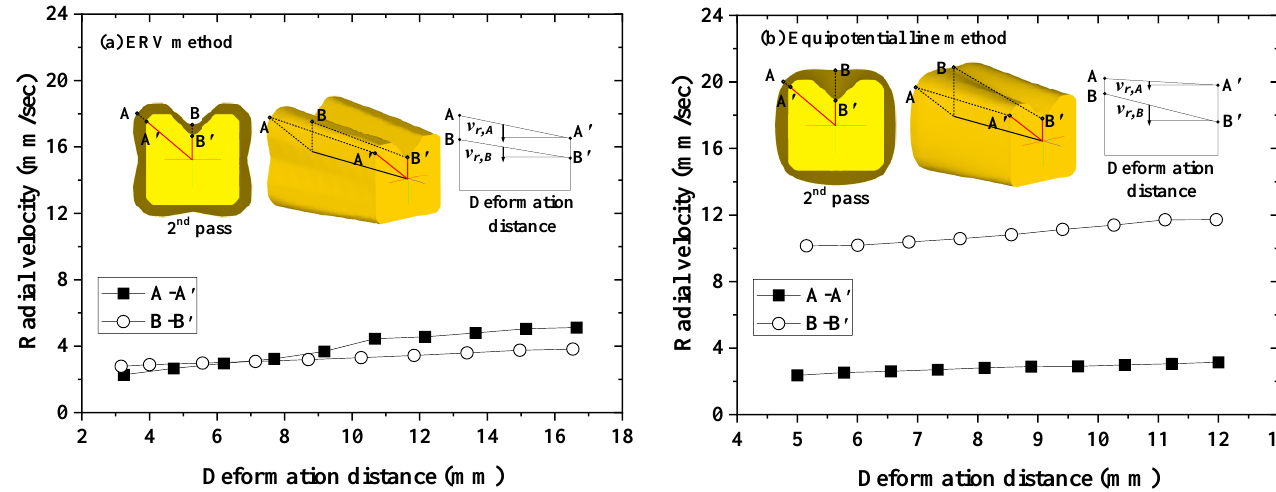
Figure 13. Comparison of the radial velocity of the second pass for the cross-roller guide: ( a ) ERV method; ( b ) equipotential line method.